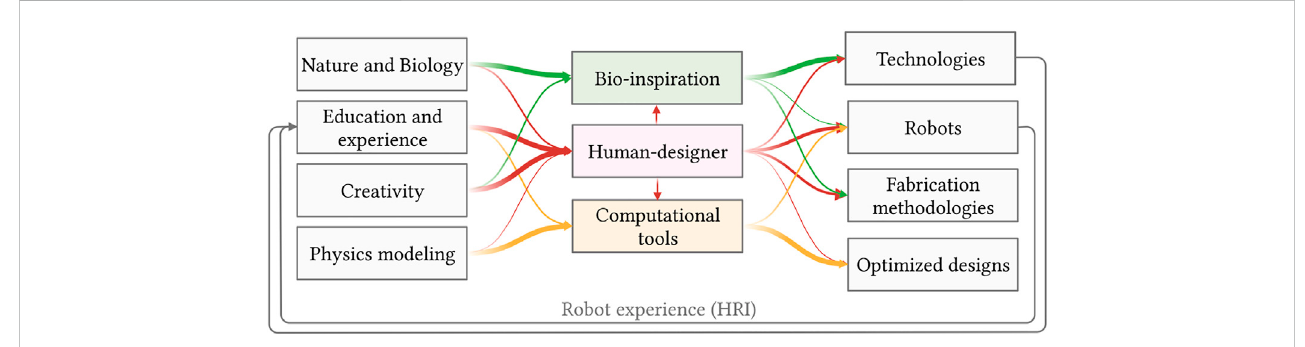
FIGURE 2 Schematic representation of the pipelines used for robot design. On the left, the pool of methods and fi elds which constitute the inspiration for robotics designs, in the center, the design approach used, and on the right the outcome of the design process. The magnitude of the arrows highlights the streams of information for the different in the pipelines, represented with arrows of different colours and intensities.